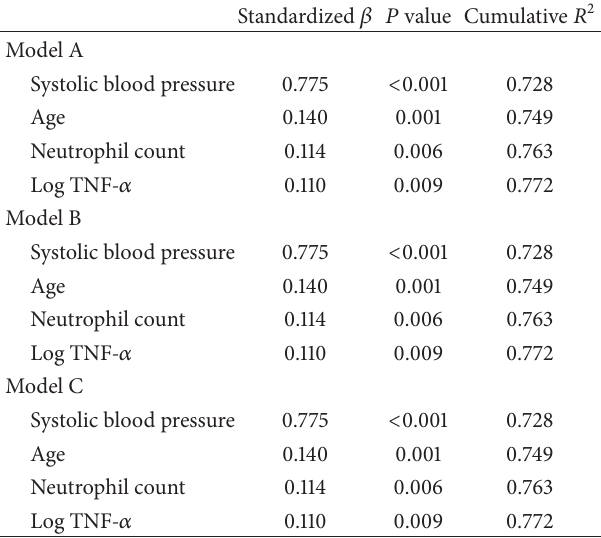
Table 2: Stepwise multiple regression analysis for pulse pressure as a dependent variable in community-dwelling elderly